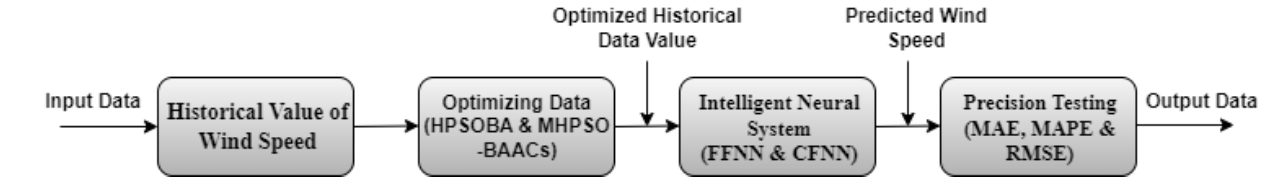
Figure 1. Block diagram of the presented system.